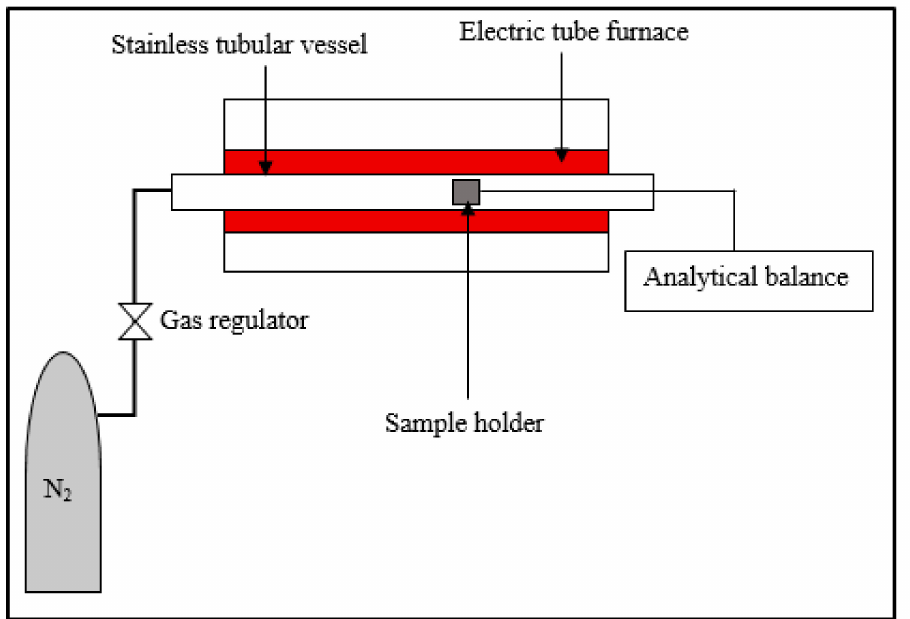
Figure 1. Schematic diagram of the torrefaction